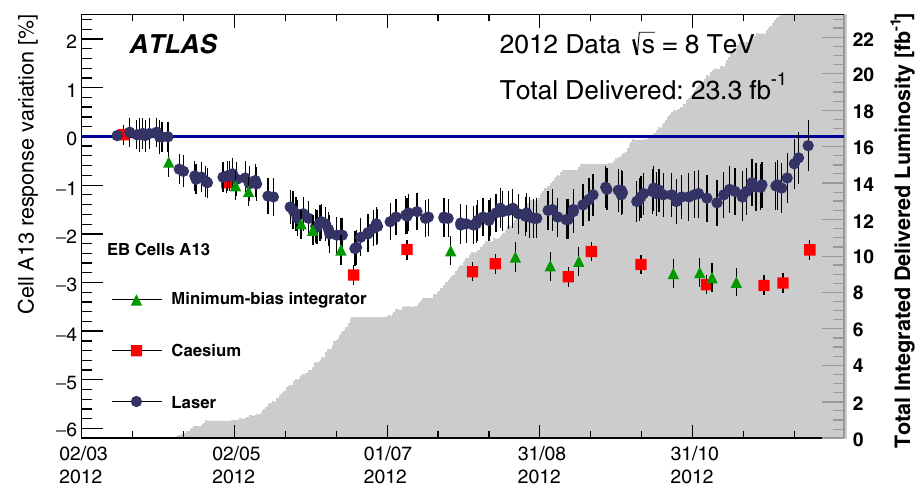
Fig. 18 ThechangeofresponseseenincellA13bytheminimum-bias, caesium, and laser systems throughout 2012. Minimum-bias data cover the period from the beginning of April to the beginning of December 2012. The Cs and laser results cover the period from mid-March to mid-December. The variation versus time for the response of the three systems was normalised to the first Cs scan (mid-March, before the start of collisions data-taking). The integrated luminosity is the total deliv-